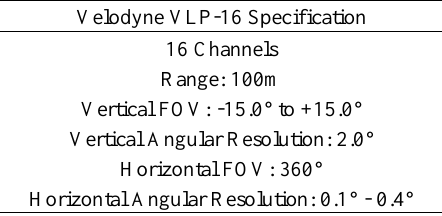
Table 1. Manufacturer specification of VLP-16